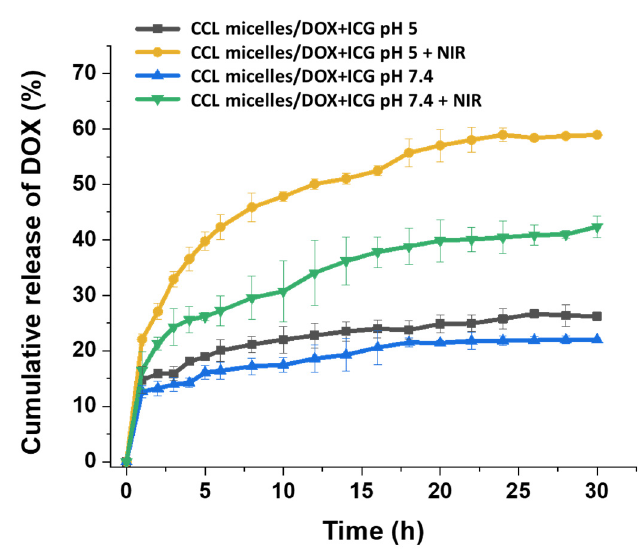
Figure 9. DOX release profile (cumulative) from CCL / ICG / DOX micelles with and without NIR irradiation in pH of 7.4 and 5.